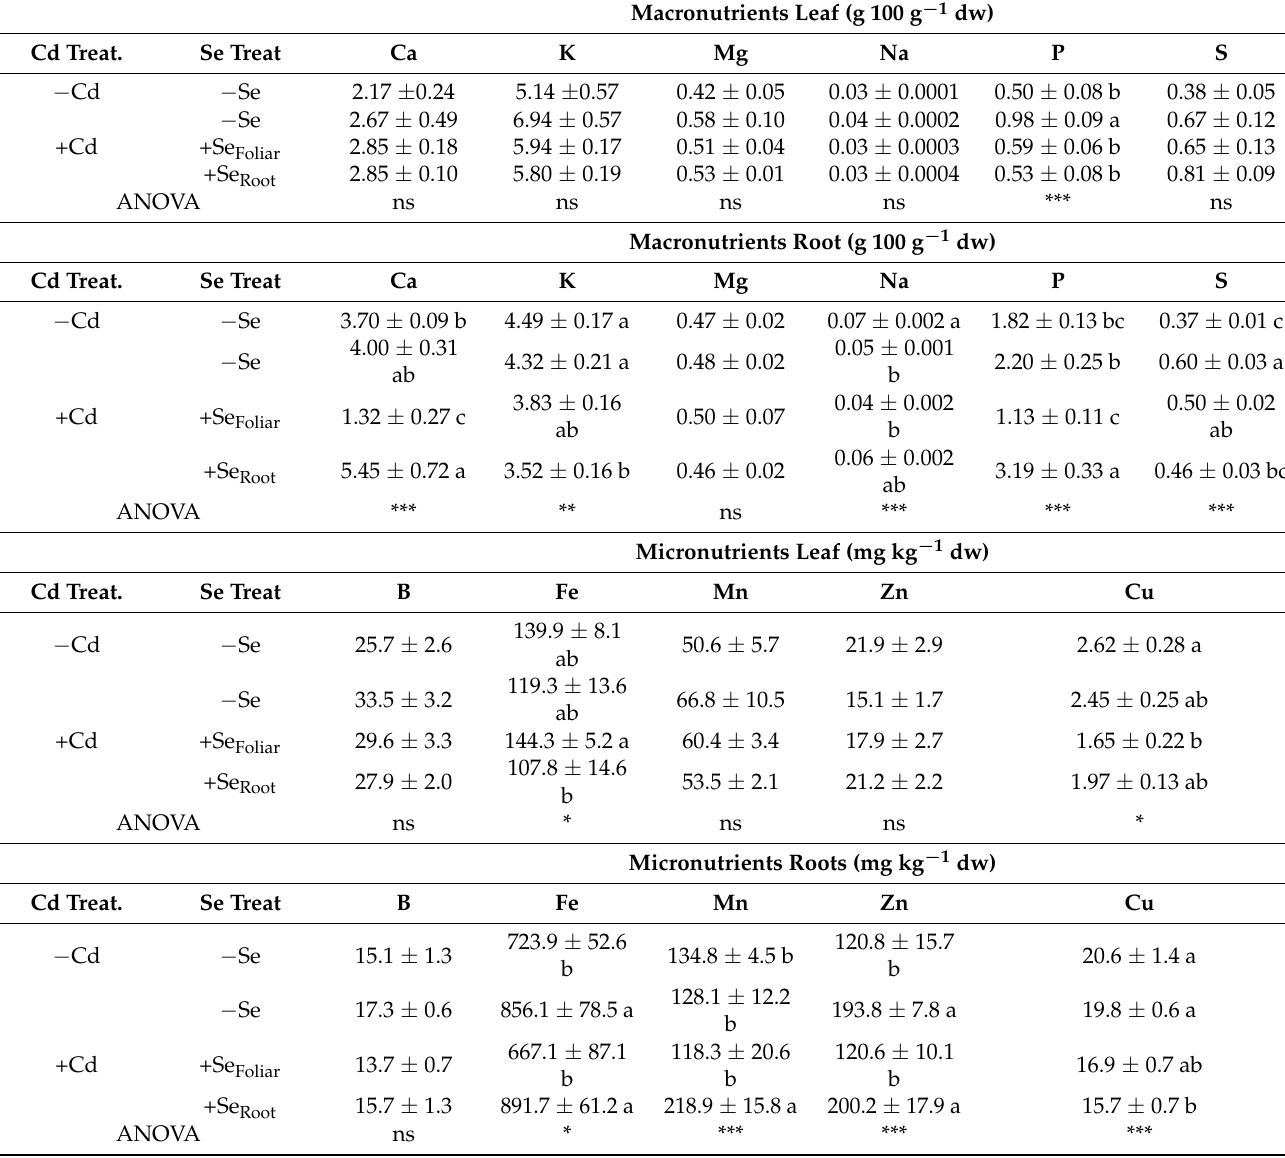
Table 2. Concentration of macro and micronutrients in leaves and roots in pepper plants under four treatments of cadmium and selenium ( − Cd/ − Se, +Cd/ − Se; +Cd/+SeF and